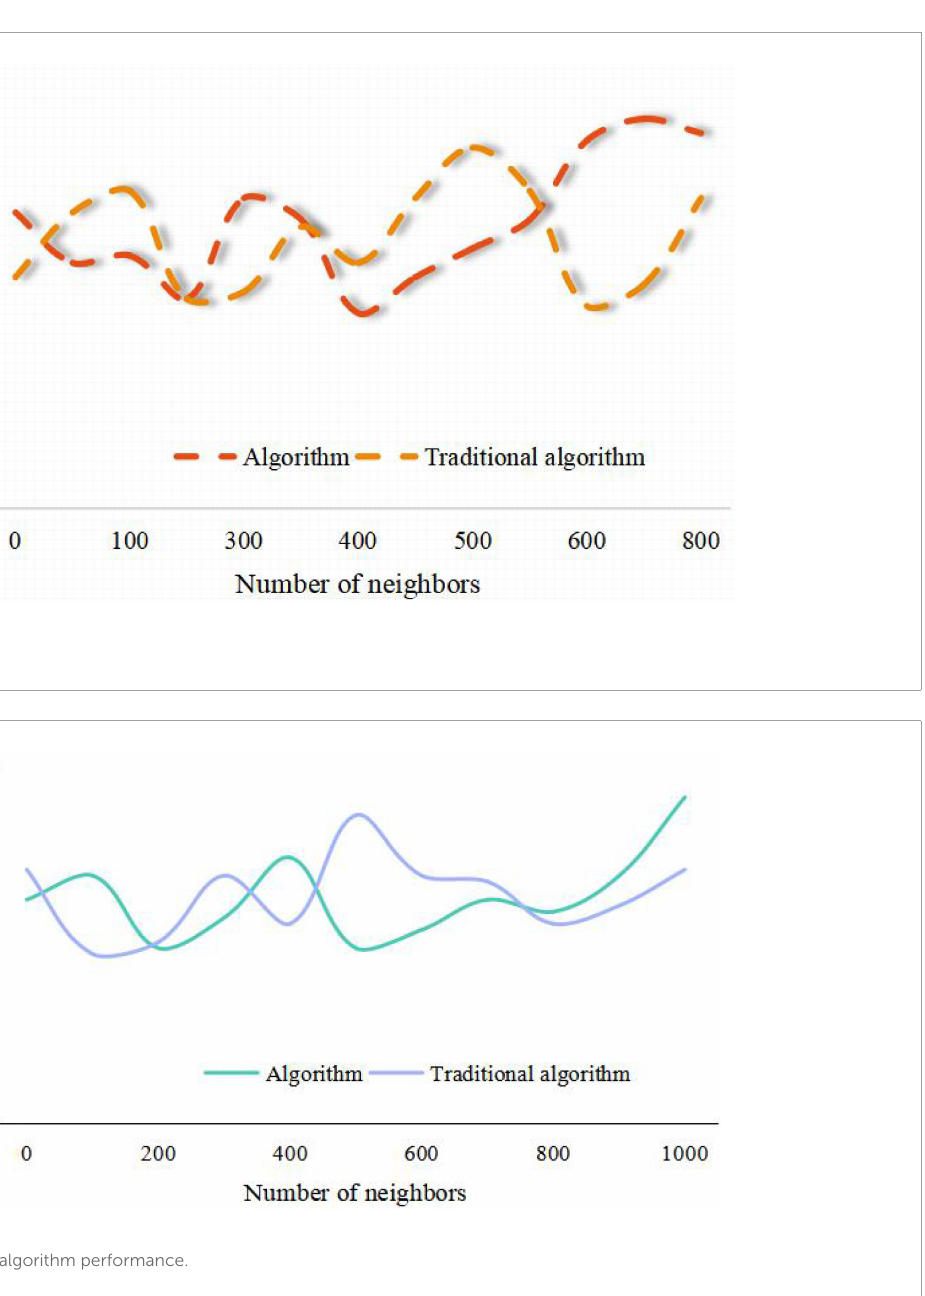
FIGURE4 Influence of support weight on algorithm